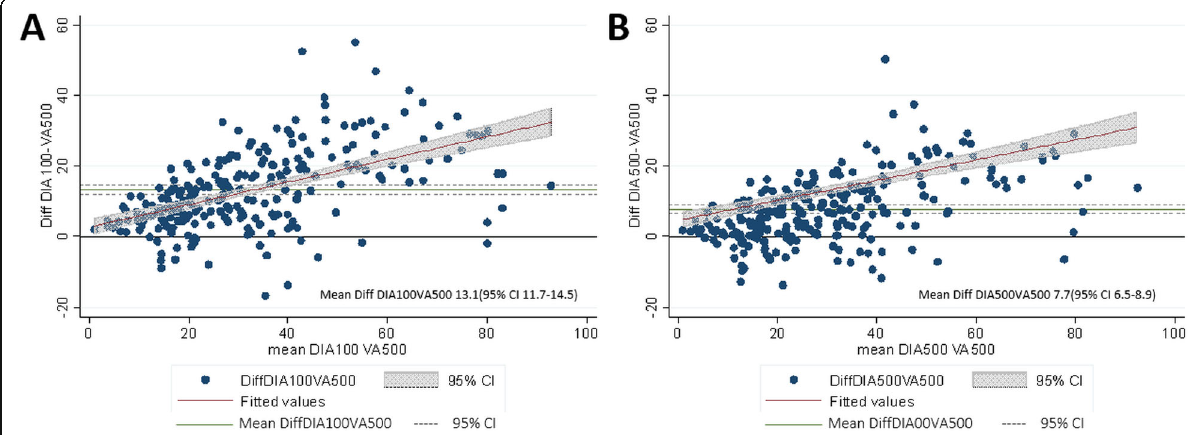
Fig. 8 Bland-Altman plots illustrating the agreement of the VA and DIA methods. A The difference between DIA100 and VA500 compared to the mean of DIA100 and VA500. B The difference between DIA500 and VA500 compared to the mean of VA500 and DIA500